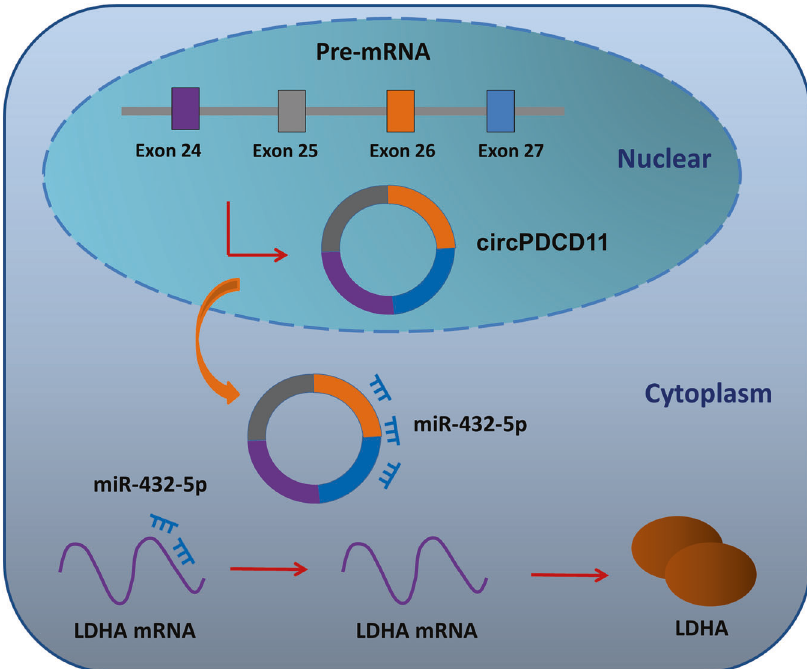
Fig. 6 The circPDCD11/miR-432-5p/LDHA axis accelerated aerobic glycolysis in TNBC